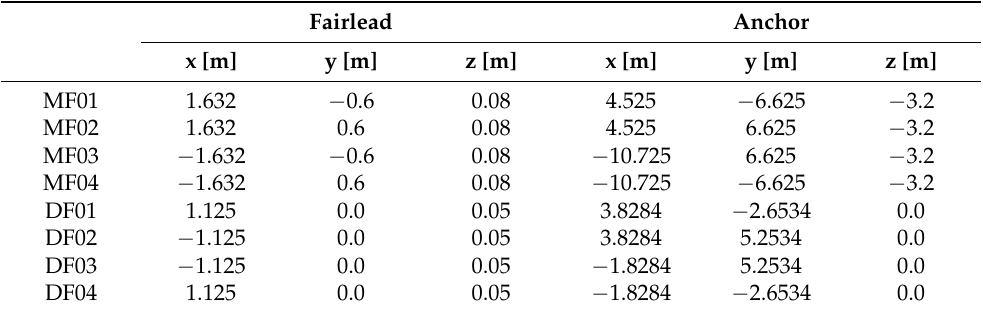
Table 3. Mooring Table 3. Mooring coordinates.